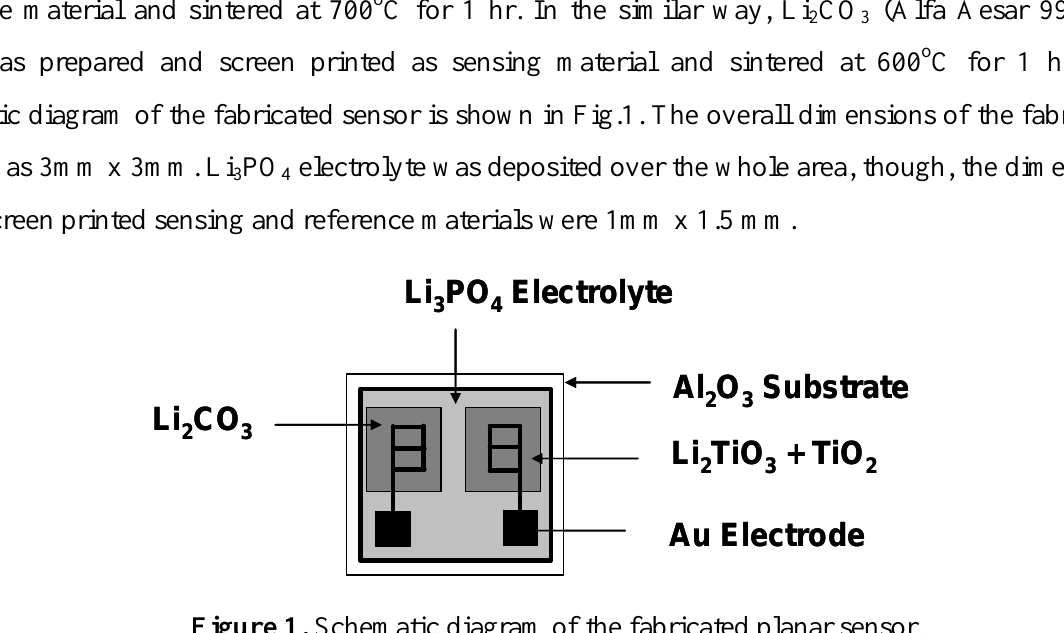
Figure 1. Schematic diagram of the fabricated planar